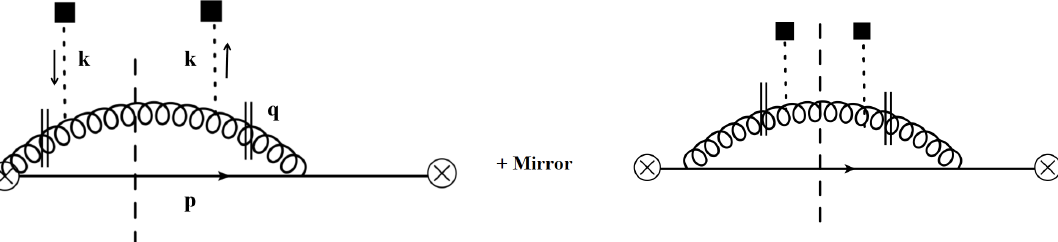
Figure 4. Gluon real interaction with the